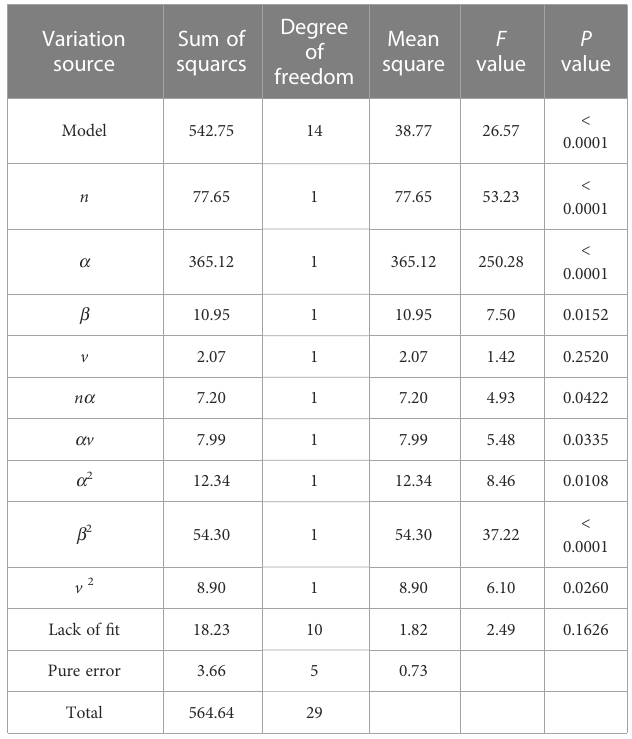
TABLE 4 ANOVA of job width.